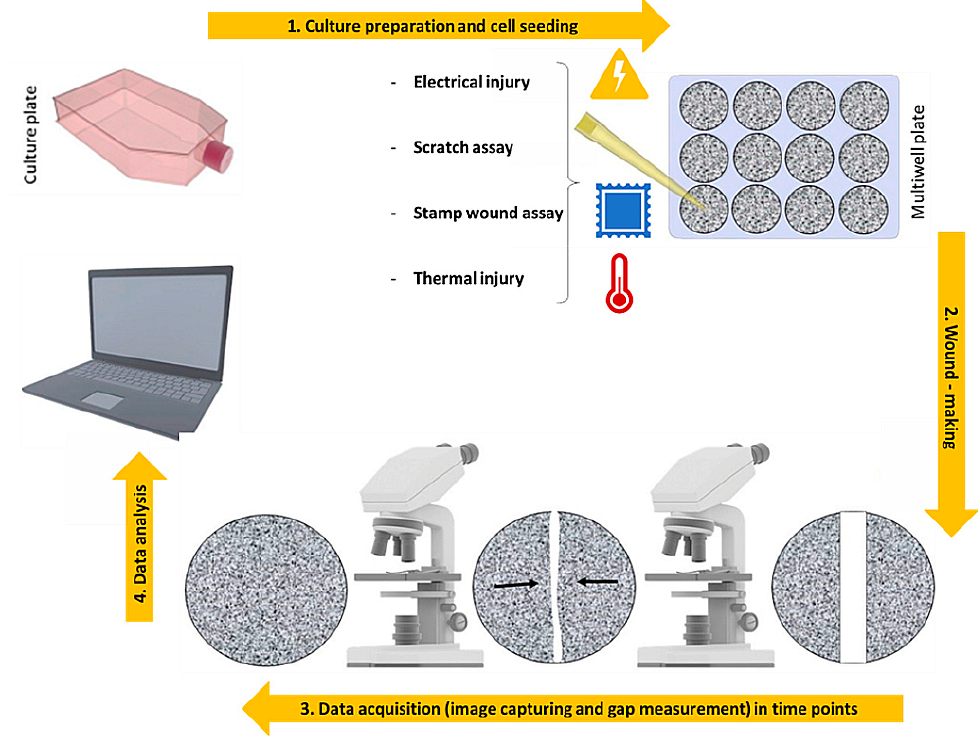
Figure 2. 2D scratch-assay steps: ( 1 ) Cell culture preparation and cell seeding into a plastic-bottomed multiwell tissue culture plates, ( 2 ) Cells confluent monolayer scratching with a pipette tip, ( 3 ) Time- lapse brightfield image acquisition of wounds up to gap closure, ( 4 ) Data analysis for mean cells migration rate estimation. Readapted from Grada A, Otero-Vinas M, Prieto-Castrillo F et al. Research Techniques Made Simple: Analysis of Collective Cell Migration Using the Wound Healing Assay. J Invest Dermatol 2017; 137:e11–6 [33] with permission from Elsevier.